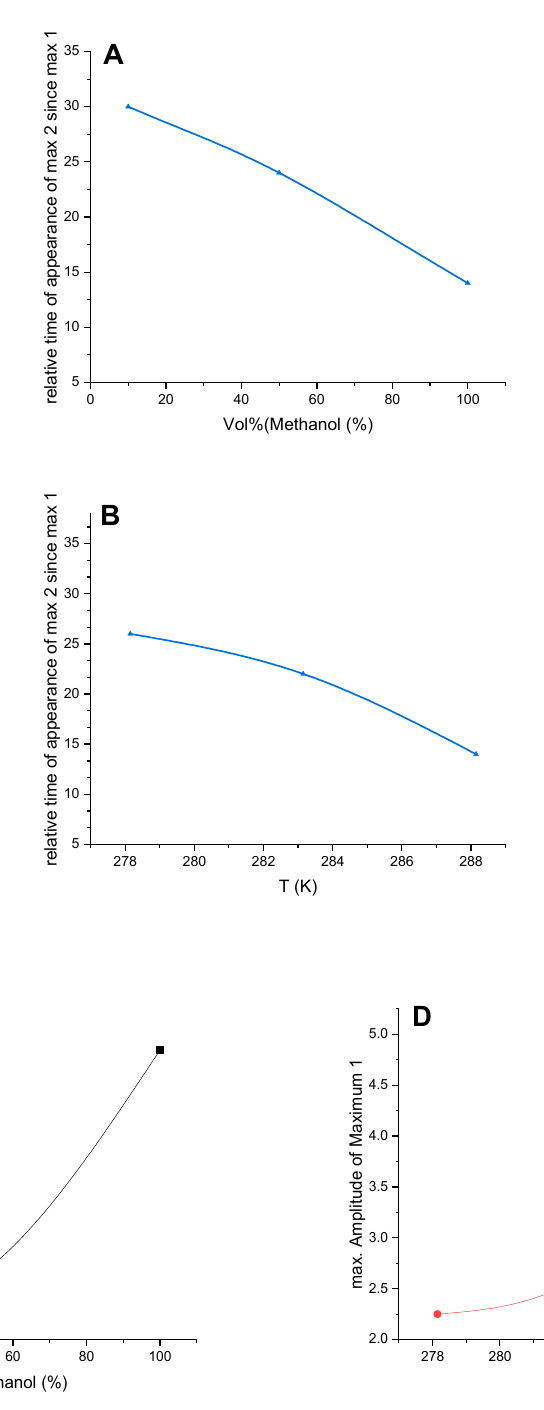
Figure 2. Concentration and temperature effects on the shape of the transient response. ( A ) relative times of the maxima in the hydrogen peroxide concentration at different methanol concentrations, ( B ) relative times of the maxima in the hydrogen peroxide concentration at different temperatures, ( C ) height of the first hydrogen peroxide maximum as function of methanol concentration, and ( D ) height of the first hydrogen peroxide maximum as function of temperature.